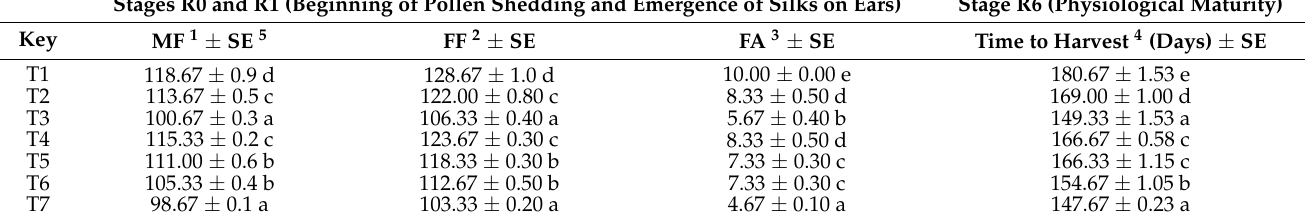
Table 3. Values of the agronomic variables evaluated during the stage of reproductive development in purple corn plants, grown under different fertilization